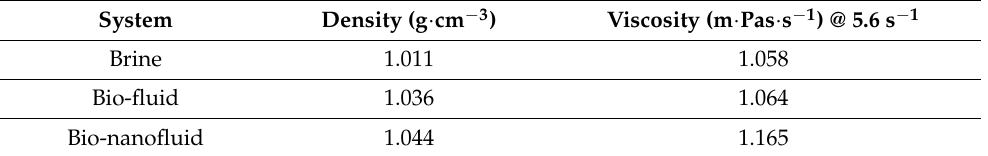
Table 6. Characterization of Density and Viscosity for Brine, bio-fluid tuned system (Brine +